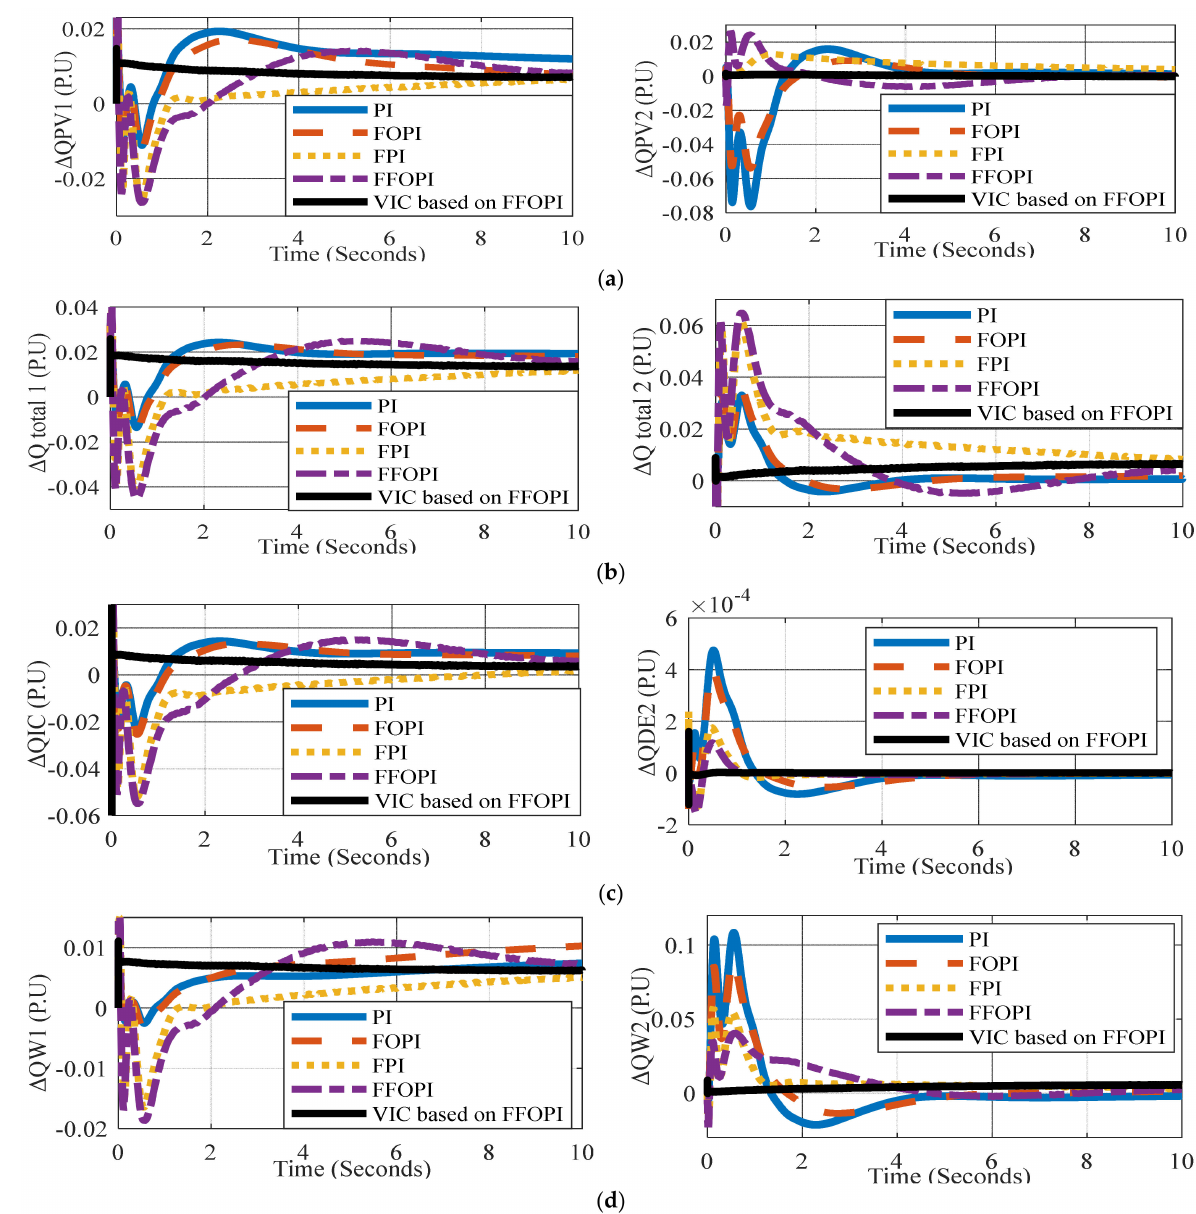
Figure 17. M 1 and M 2 ’s reactive power measurements versus time for each controller at solar radiation disturbance: ( a ) ∆ Q PV1 (PU), ∆ Q PV2 (PU), ( b ) ∆ Q total 1 (PU), ∆ Q total 2 (PU), ( c ) ∆ Q IC (PU), ∆ Q ∆ Q ∆ Q DE2 (PU), ( d ) W1 (PU), W2